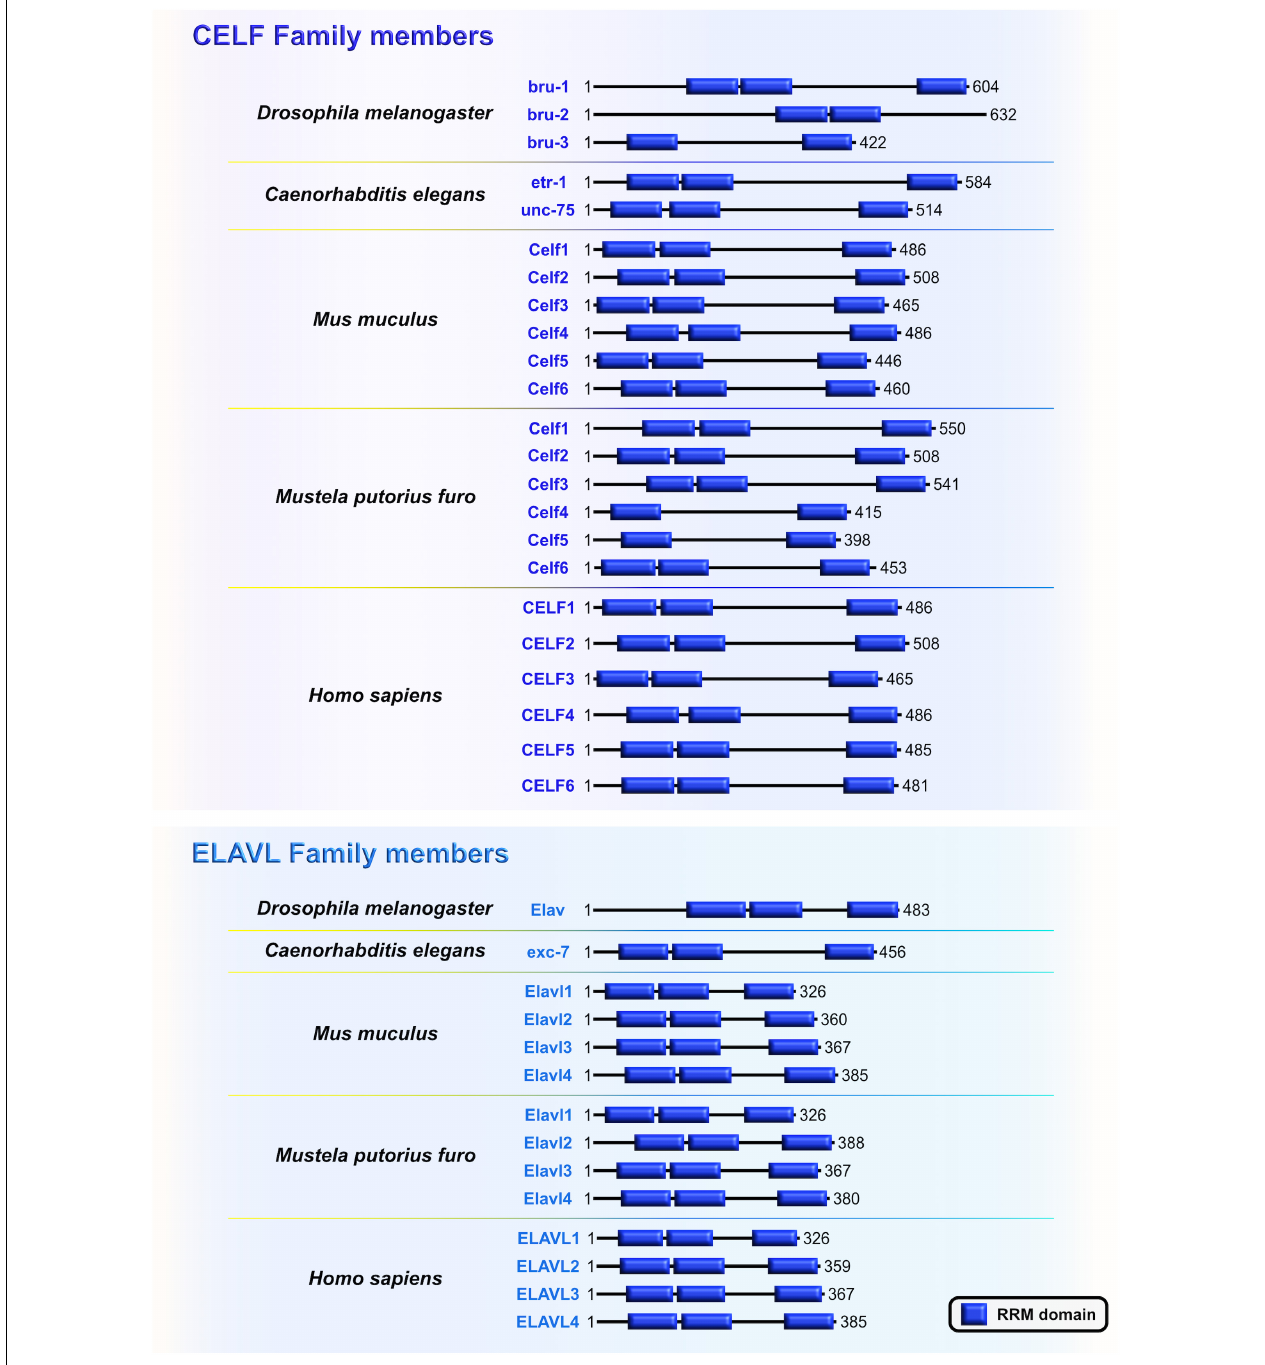
FIGURE 5 | The CUGBP, ELAVL-like family (CELF) and embryonic lethal, abnormal vision-like (ELAVL) family members are closely related. Similarities and differences of RNA-binding domain, RNA Recognition Motif (RRM; blue) which is present in evolutionarily conserved RNA-binding proteins (RBPs) CELF and ELAVL in Drosophila melanogaster , Caenorhabditis elegans , Mus musculus , Mustela putorius furo , and Homo sapiens according to UniProt database (https://www.uniprot.org) and NCBI (https://www.ncbi.nlm.nih.gov/). The UniProtKB of NCBI accession numbers are indicated below for each member of CELF and ELAVL family in D. melanogaster : Bruno (bru)-1 (Q960Z4), bru-2 (Q7K108), bru-3 (Q9VU91), and Embryonic Lethal, Abnormal Vision (Elav) (P16914); C. elegans : ELAV-Type RNA binding-protein family (etr)-1 (G5EF03), uncoordinated (unc)-75 (G5EE68), and excretory canal abnormal (exc)-7 (Q20084); M. musculus : Celf1 (P28659), Celf2 (Q9Z0H4), Celf3 (Q8CIN6), Celf4 (Q7TSY6), Celf5 (A0A5F8MPH2), Celf6 (Q7TN33), and Elavl1 (P70372), Elavl2 (Q60899), Elavl3 (Q60900), Elavl4 (Q61701); M. putorius furo : Celf1 (M3XXX8), Celf2 (M3YY92), Celf3 (M3XWY8), Celf4 (M3XPL9), Celf5 (M3XX93), Celf6 (XP_004758414.1), and Elavl1 (M3Y9C6), Elavl2 (M3YX03), Elavl3 (M3Y100), Elavl4 (M3Y730); and H. sapiens : CELF1 (Q92879), CELF2 (O95319), CELF3 (Q5SZQ8), CELF4 (Q9BZC1), CELF5 (Q8N6W0), CELF6 (Q96J87), and ELAVL1 (Q15717), ELAVL2 (Q12926), ELAVL3 (Q14576), ELAVL4 (P26378).